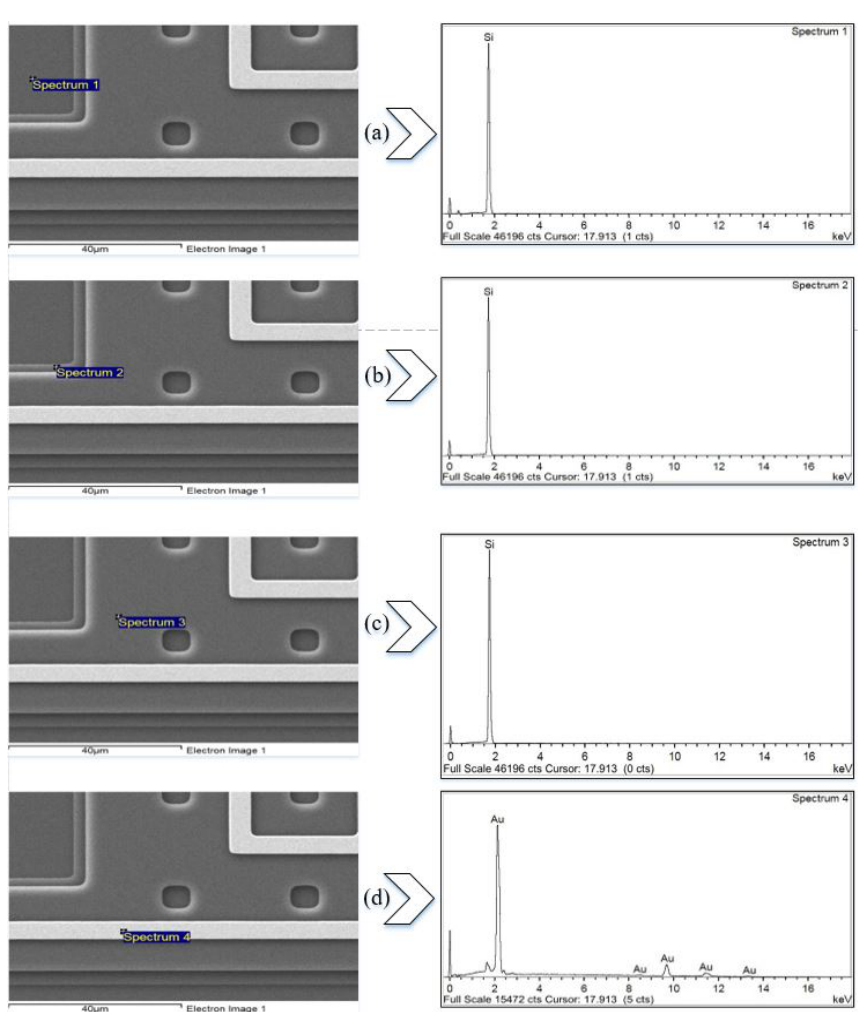
Figure 8. EDX analysis of the different layers of the PolyMUMPs sensor for ( a ) silicon substrate, ( b ) Poly0, ( c ) Poly2, and ( d )